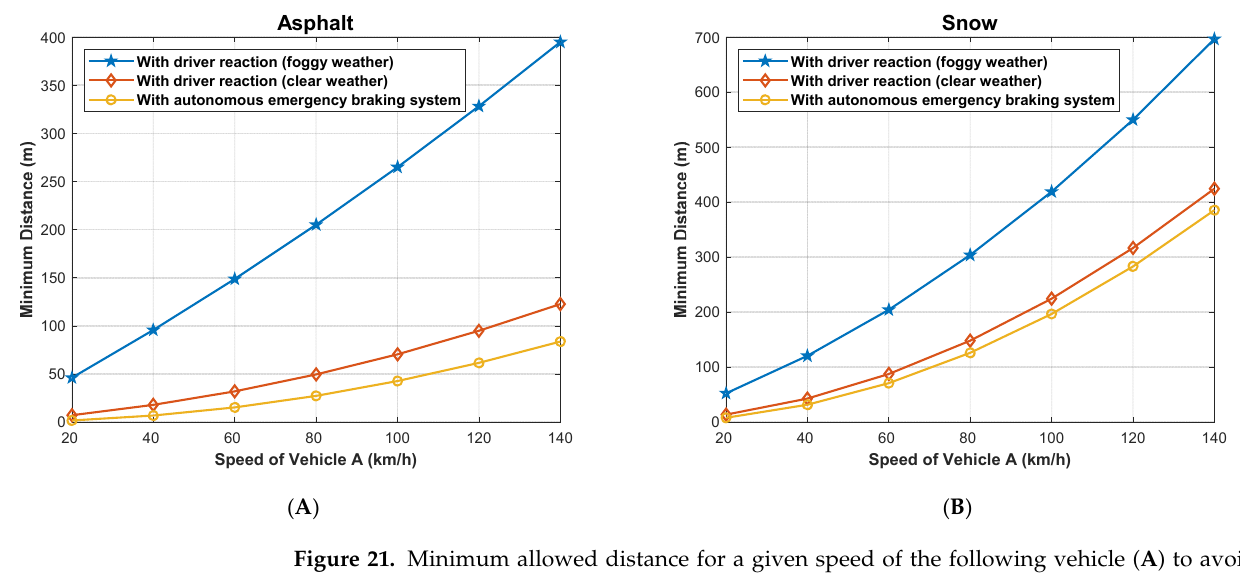
Figure 21. Minimum allowed distance for a given speed of the following vehicle ( A ) to avoid a collision, assuming that the followed vehicle ( B ) stops suddenly.